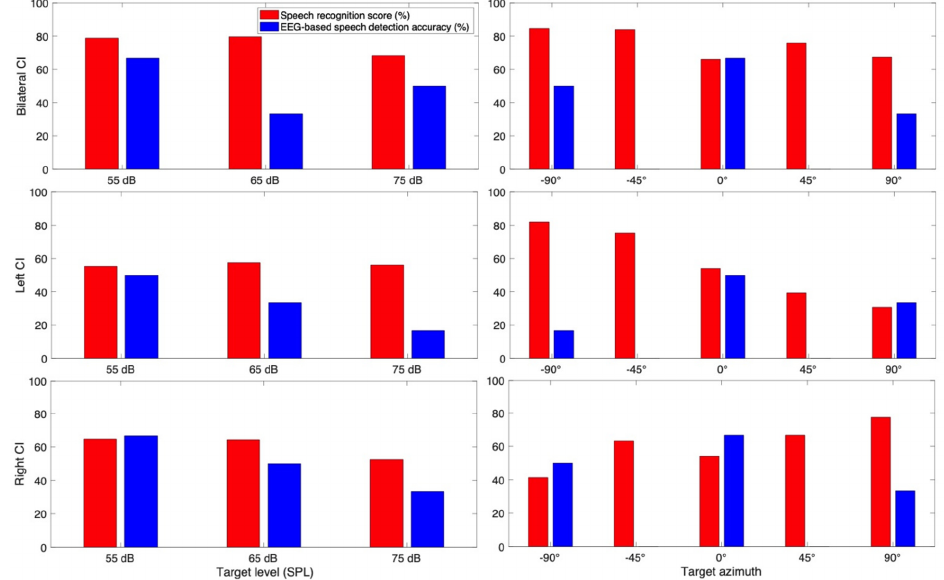
Figure 5. Speech recognition score and speech detection accuracy from EEG for CI 1.